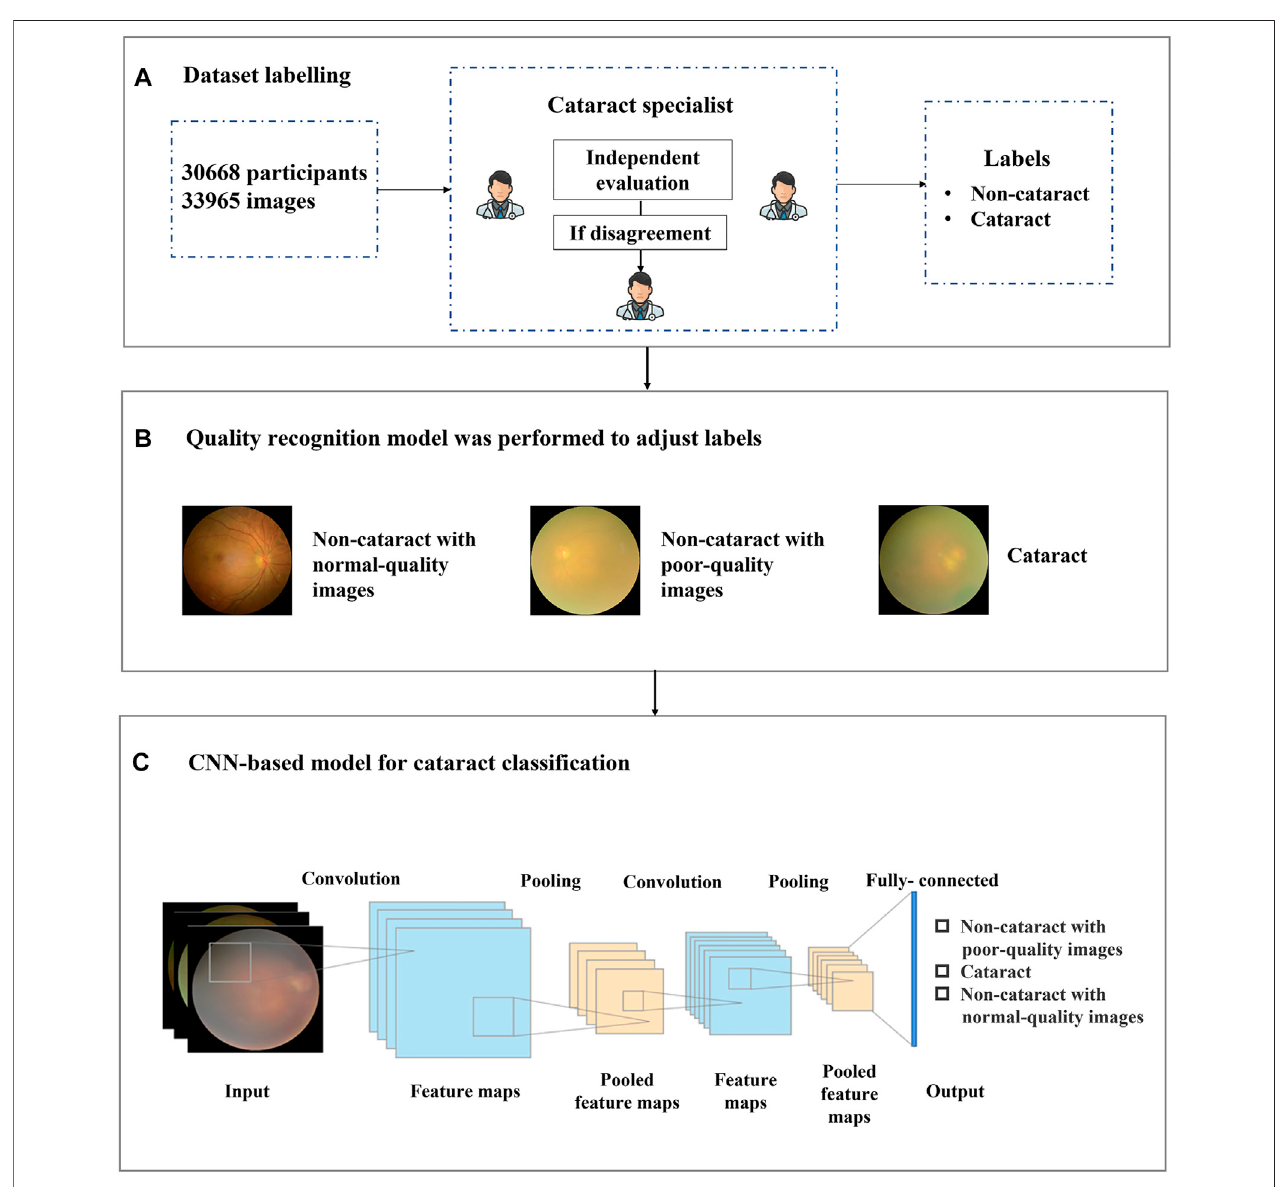
FIGURE 1 | Overall training pipeline for the cataract arti fi cial intelligence model. (A) the dataset included 33,965 images of 30,668 participants. Each image was independentlylabeledbytwoexperiencedophthalmologists,andathirdophthalmologistwasconsultedifadisagreementarosebetweentheinitialophthalmologists. (B) all 33,965 images with binary-class diagnosis labels were adjusted and reassigned to three categories of labels by the quality recognition model. (C) all 33,965 images were input to the convolutional neural networks-based model for training and validating the antiinterference cataract arti fi cial intelligence classi fi cation model.